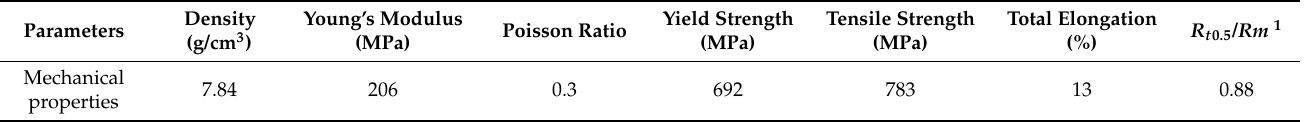
Table 2. Mechanical properties of X90 pipeline